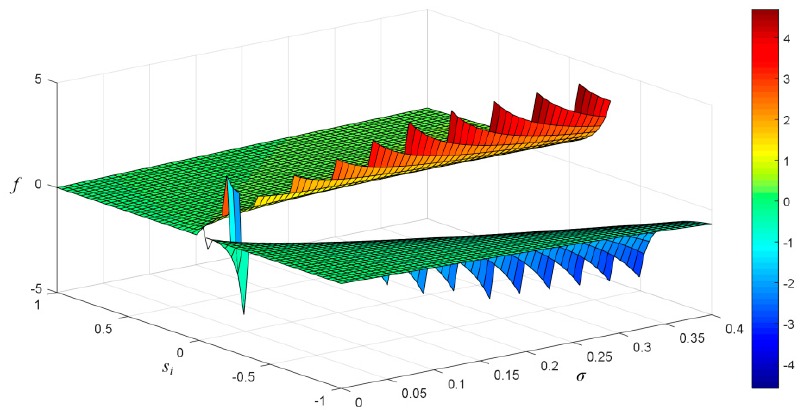
Figure 5. Surface graph of σ / ( s i + σ ) .